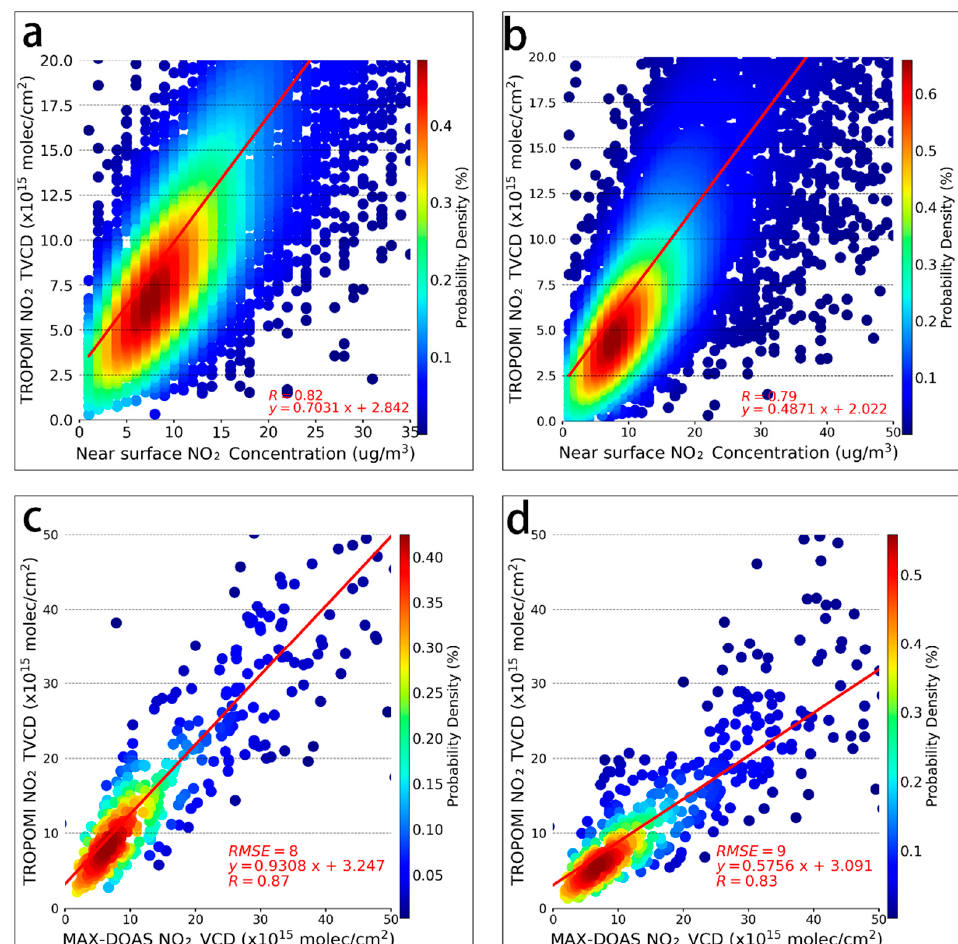
Figure 2. Correlation between the TROPOMI NO 2 TVCD product and other observations. ( a ) USTC product and ground-level NO 2 concentrations (14:00 local time) in Beijing, ( b ) official product and ground-level NO 2 concentrations (14:00 local time) in Beijing. ( c ) USTC product and MAX-DOAS NO 2 VCD at the CAMS site, ( d ) official product, and MAX-DOAS NO 2 VCD at the CAMS site.